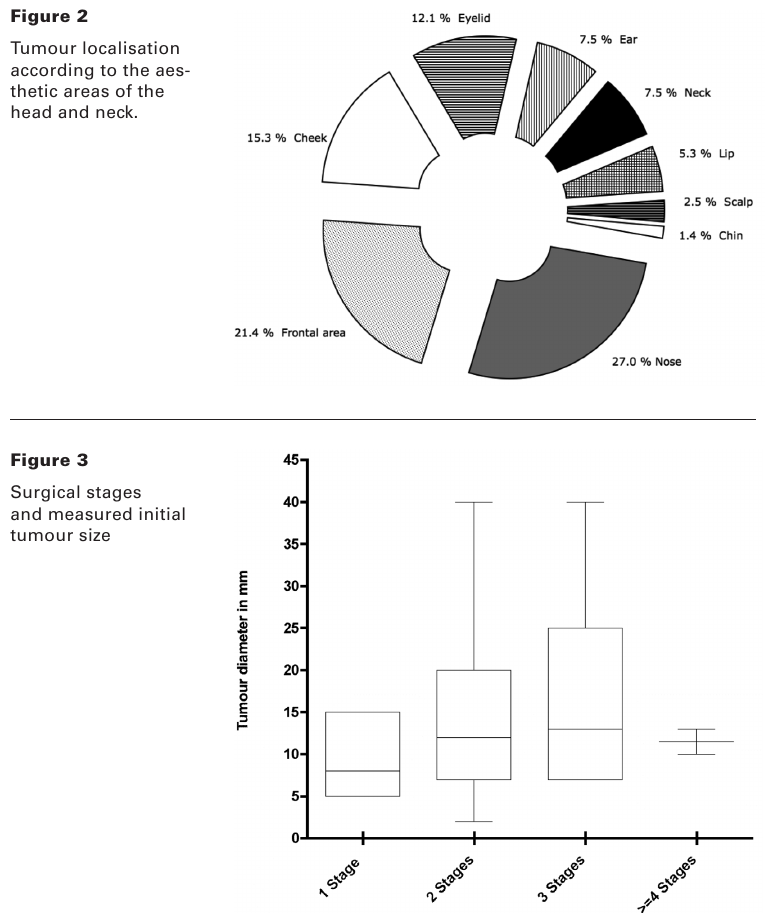
Surgical stages and measured initial tumour size